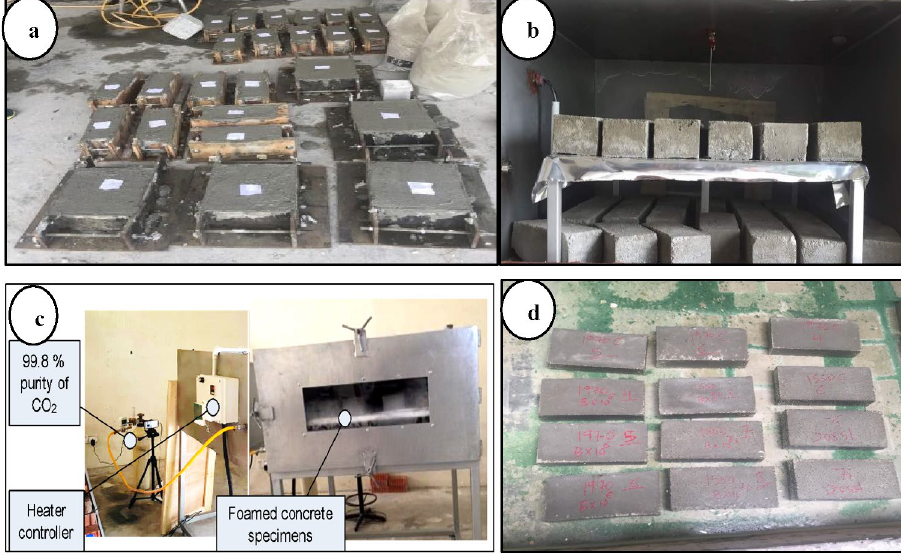
Figure 2. Concrete specimens ( a ) demoulding specimens, ( b ) placing specimens in a chamber, ( c ) curing of specimens in chamber ( d ) curing of specimens in